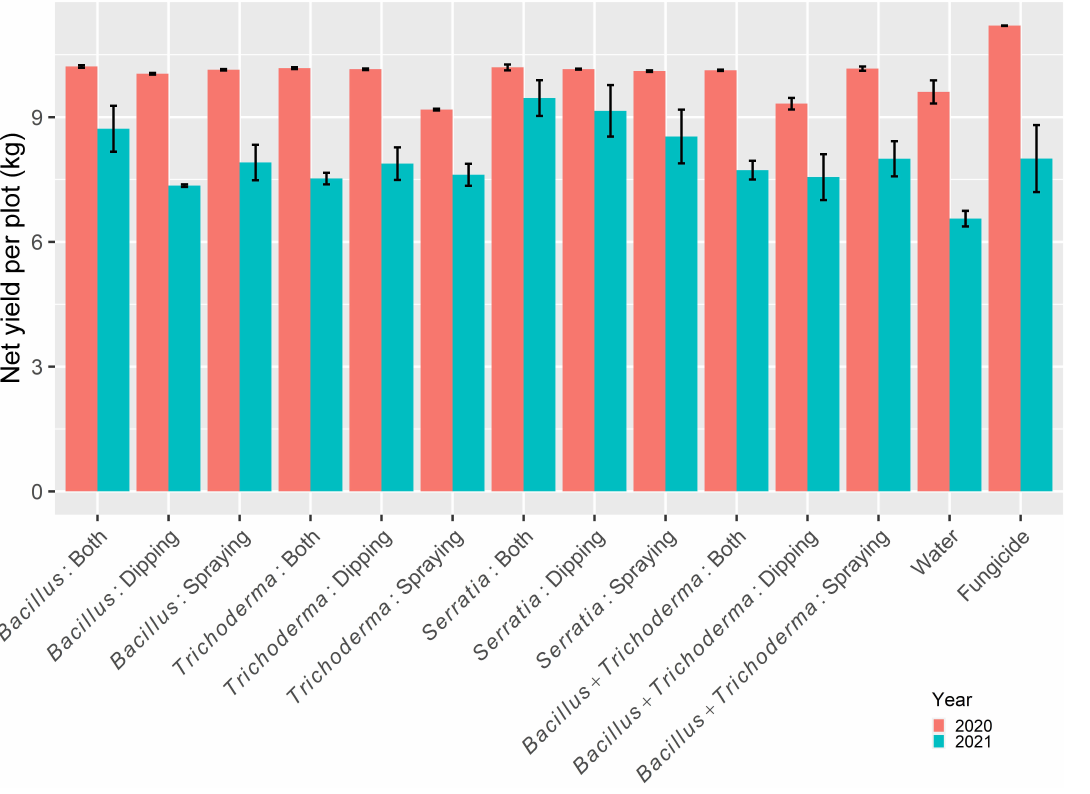
Figure 4. Net grain yield (kg) per plot (size 5 × 5 m) where one of the four biopesticides was applied at different times (dipping at transplanting, foliar spraying post-transplanting, or at both times) at one site in 2020 and 2021 in Kenya. Two controls (water as negative, and fungicide as positive) were included for comparison. The bar represents one standard